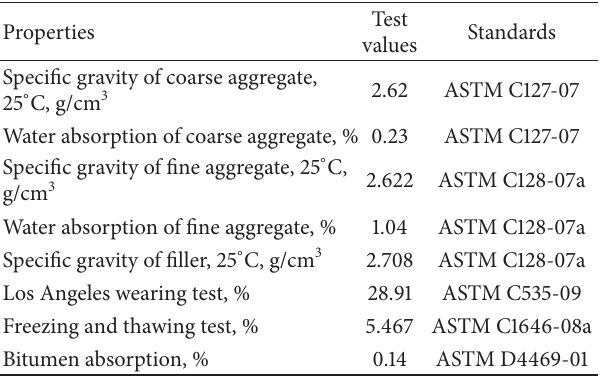
Figure 1: Aggregate grading curves for asphalt mixtures compared with the current GDTH. Table 1: Physical characteristics of the aggregates used in the tests.